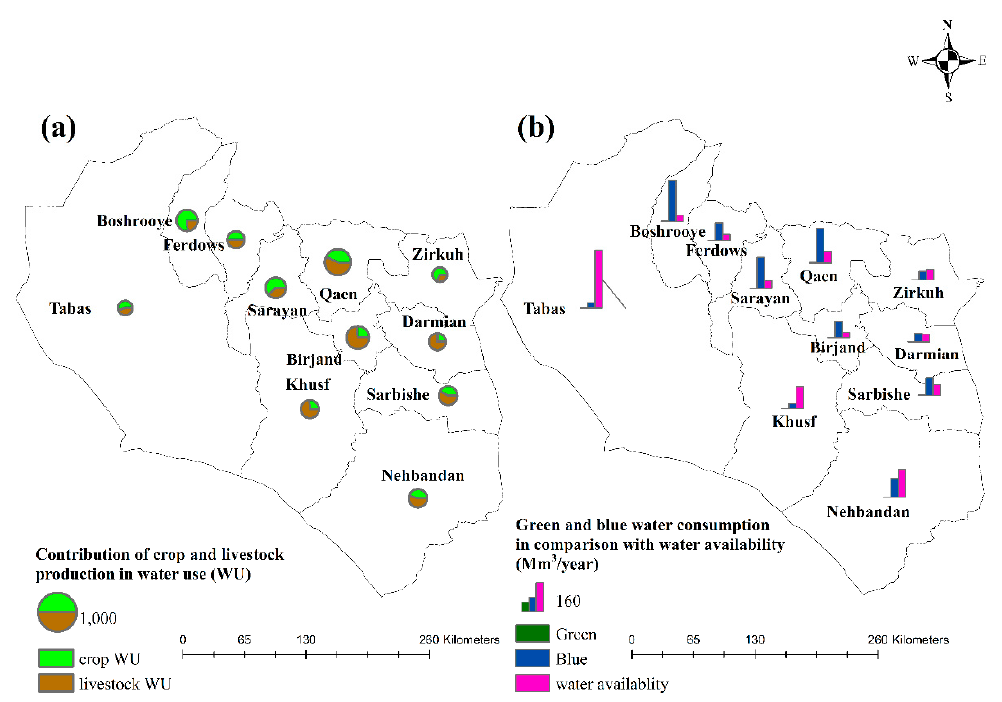
Figure 8. The fractional contribution of crop and livestock production in water withdrawal in each county ( a ), and green and blue water usage in comparison with water availability ( b ). The size of circles represents the total volume of water withdrawal.